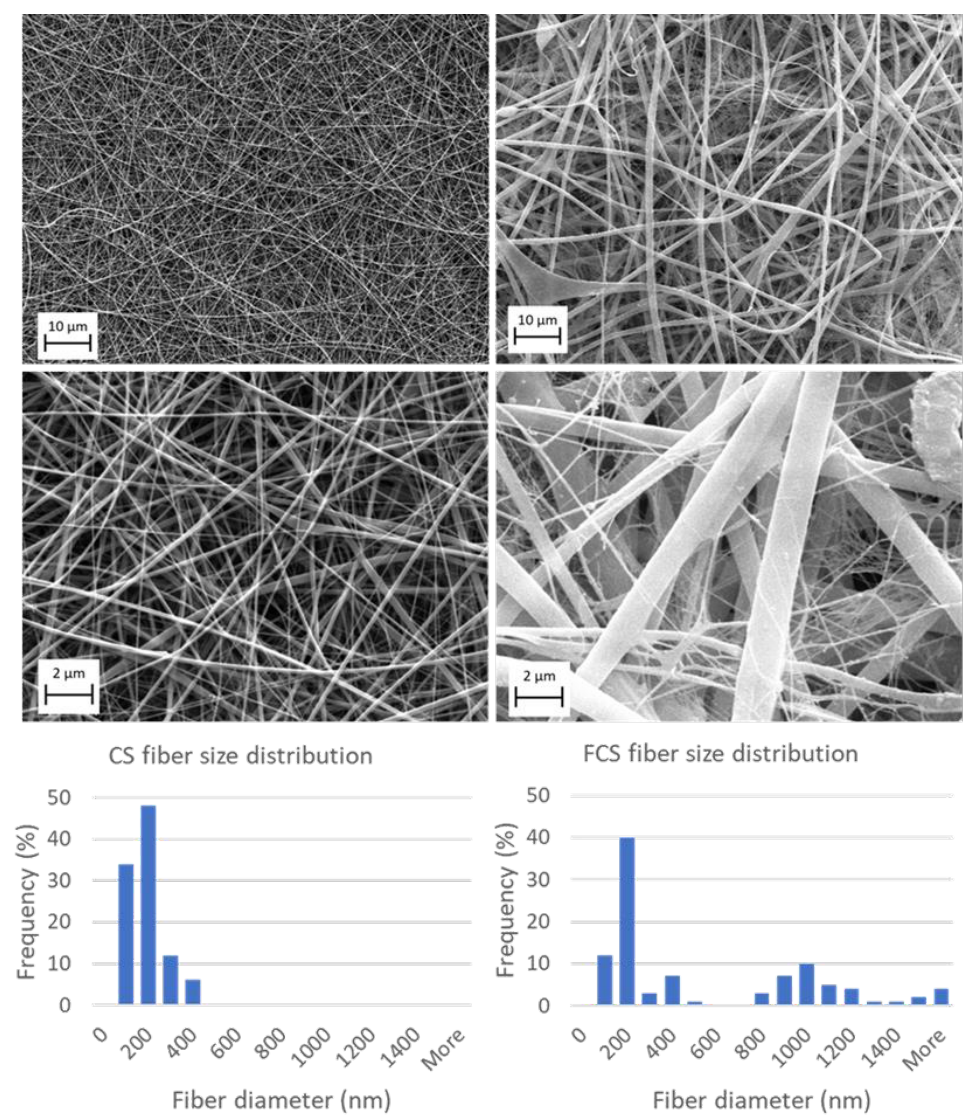
Figure 1. SEM and fiber diameter distributions of chitosan (CS, left column) and fibrinogen/chitosan (FCS, right column) scaffolds.